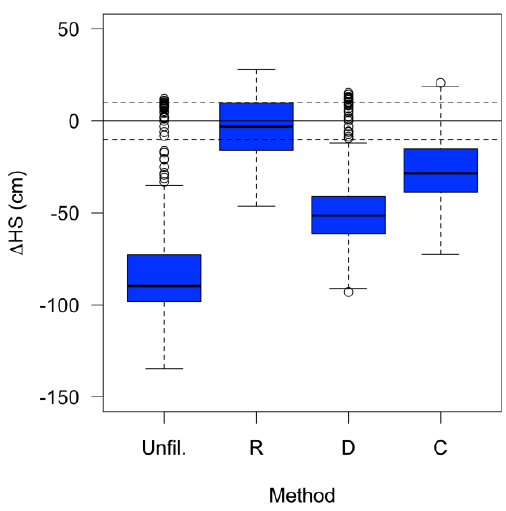
Fig. 3. Difference between simulated and observed snow heights for simulations using unfiltered and bias corrected precipitation Figure 3: Difference between simulated and observed snow heights for simulations 61 amounts. Dashed lines are located at ± 10cm. Replaces Fig. 4 in Bellaire et al.